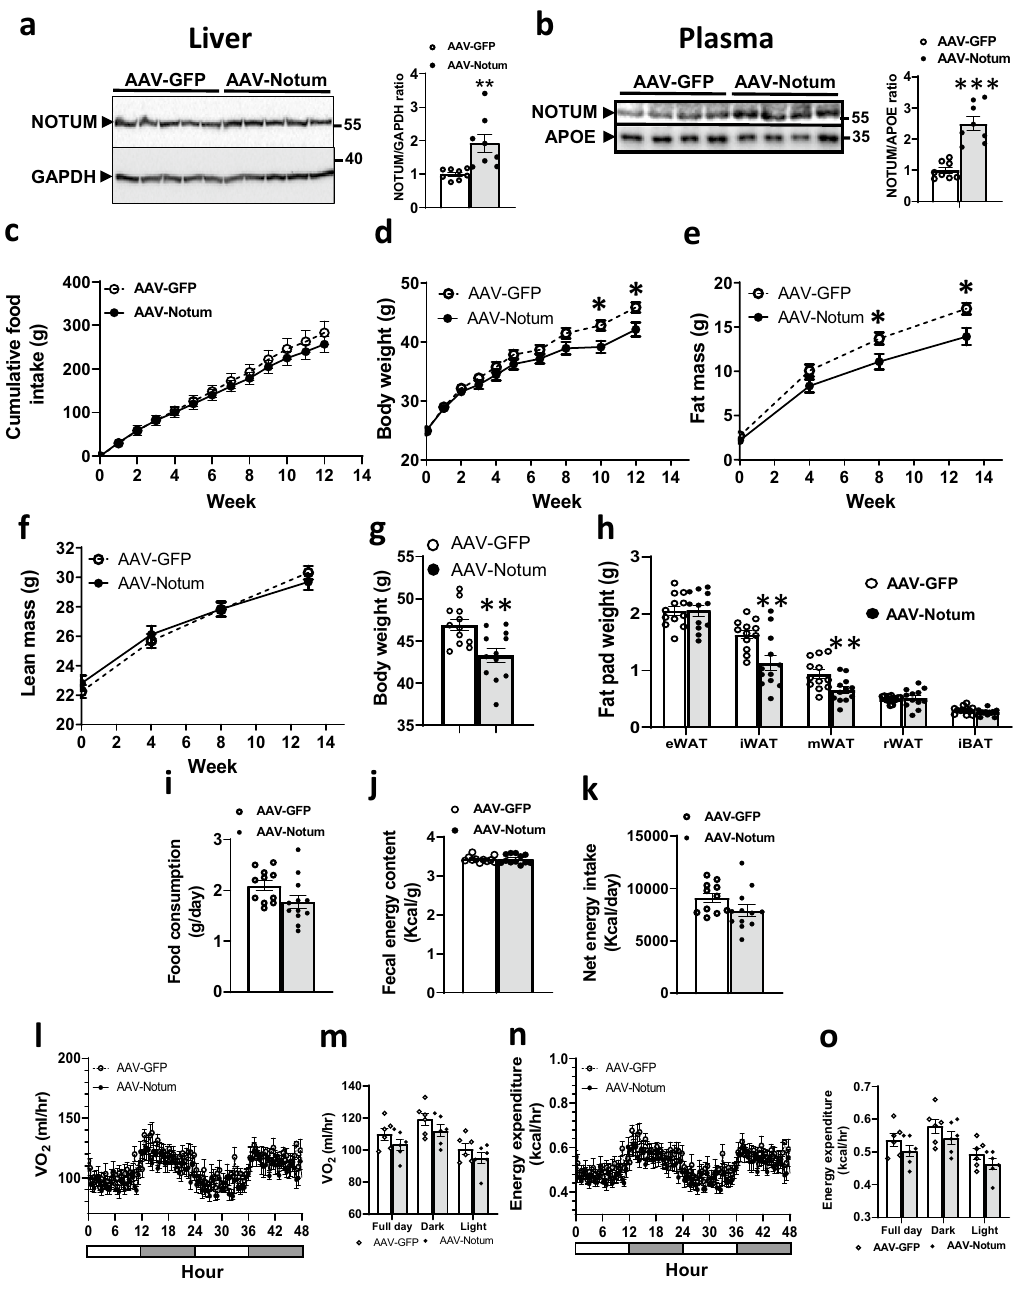
Figure 1. NOTUM overexpression protects against diet-induced obesity in mice. ( a – k ) Male C57BL/6J mice were infected with AAV-GFP or AAV-Notum (n = 12 per group) and fed a HF/HS diet for 14 weeks to induce obesity. ( a ) Liver NOTUM and GAPDH protein levels as determined by immunoblotting (n = 8/group). The images shown for NOTUM and GAPDH were from different parts of the same blot. Liver NOTUM/GAPDH ratios are shown in the right panel. ( b ) Plasma NOTUM and APOE levels as determined by immunoblotting. n = 8/group. The images shown for NOTUM and APOE were from different parts of same blot. The plasma NOTUM/APOE ratios are shown in the right panel. ( c ) Average cumulative food intake per mouse during the first 12 weeks of diet feeding is shown. Body weight ( d ), fat mass ( e ), and lean mass ( f ) of mice during the diet feeding period are shown. n = 12/group. At euthanasia (14 weeks), body weight ( g ), and weights of eWAT, iWAT, mWAT, rWAT, and iBAT ( h ) were measured. n = 12/group. ( i – k ), n = 11 to 12/group: After five-week feeding of the HF/HS diet, mice were individually housed for 48 h for measurements of food consumption ( i ). Fecal samples were collected for determination of fecal energy content ( j ). ( k ) Net energy intake was then calculated (see “Material and methods” section). ( l – o ) In an independent experiment, AAV-GFP and AAV-Notum infected mice (n = 6/group) were fed a HF/HS diet for 6 weeks before the mice were individually housed in metabolic cages for 3 days for measurement of energy expenditure by indirect calorimetry. Oxygen consumption rate, ( l ) and ( m ), and energy expenditure rate ( n ) and ( o ) are shown. Symbols: *: p < 0.05, **: p < 0.01, ***: p < 0.001, AAV-GFP versus AAV-Notum as determined by Student’s